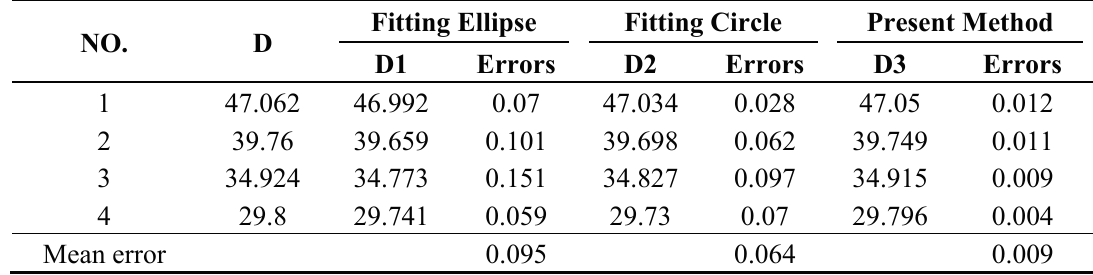
Table 5. Comparison of the measured diameters in shaft1